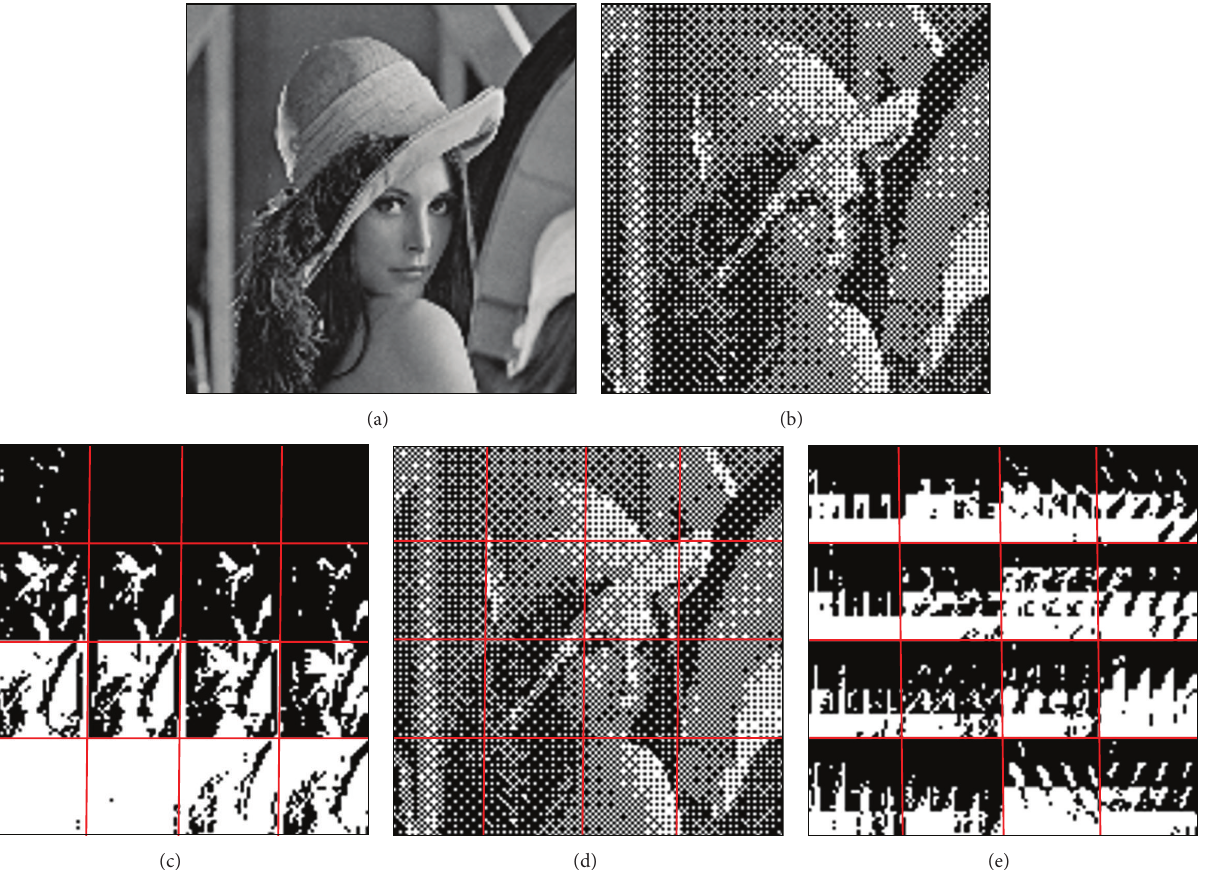
Figure 2: An example of bit-interleaving algorithm [12]. (a) Lena image. (b) Dithering halftone image of (b) using Figure 1(a). (c) Bit- interleaving result of (b). (d) Dithering halftone image divided into 16 subimages. (e) The result of applying bit-interleaving to each subimage in